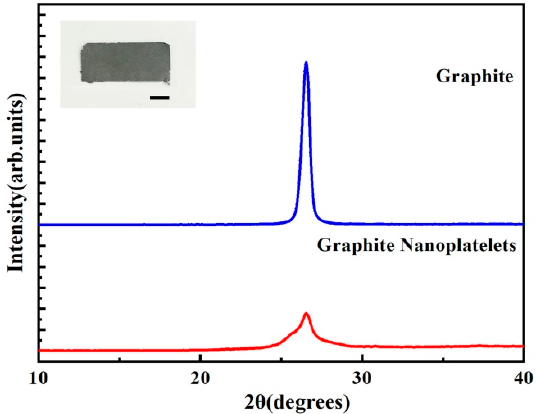
Figure 1. XRD diffraction patterns of graphite and GNPs. The inserted picture is the photograph of GNP sheets. The scale bar is 5 mm. S ensors 2019 , 9 , x FOR PEER REVIEW